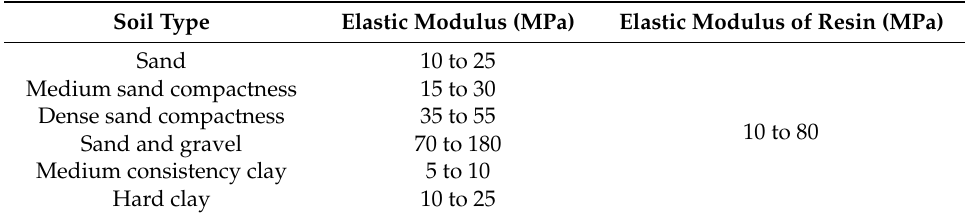
Figure 1. Images obtained with the electron microscope of the Geoplus expanding polyurethane resin without confinement (density equal to 37 kg/m 3 ). ( a ) Enlarged × 100; ( b ) Enlarged × 200. Table 1. Elastic modulus in different types of soil.